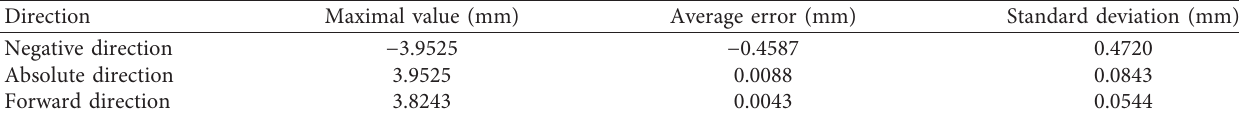
Figure 15: 3D point cloud of the depth map with reflection coefficient from 0.60 to 0.75: (a) traditional ADFP method; (b) our method. Table 4: Evaluation and analysis of the point cloud by the traditional ADFP method for Figure 15.